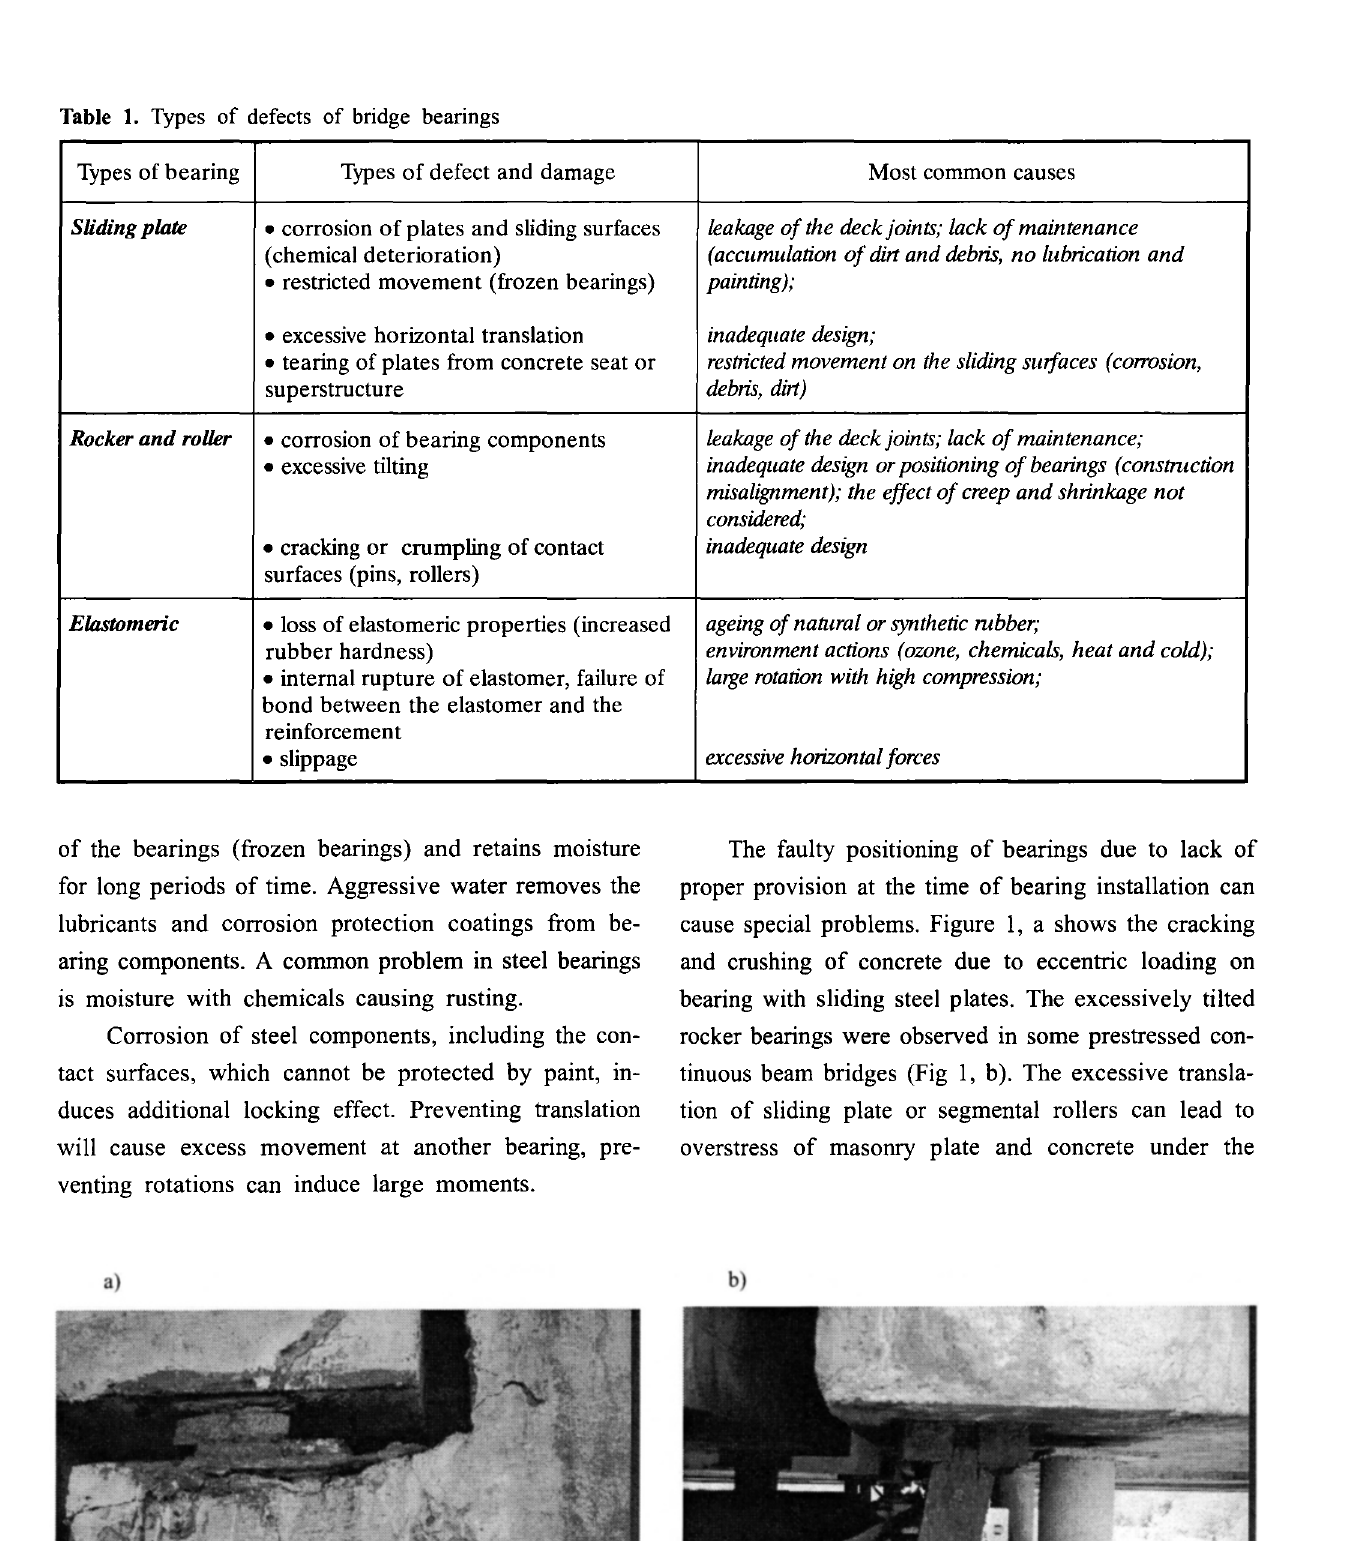
Fig 1. Deterioration of bridge girder corbel due to faulty positioning and rusting of steel sliding bearing (a) and excessive tilting of rocker bearing